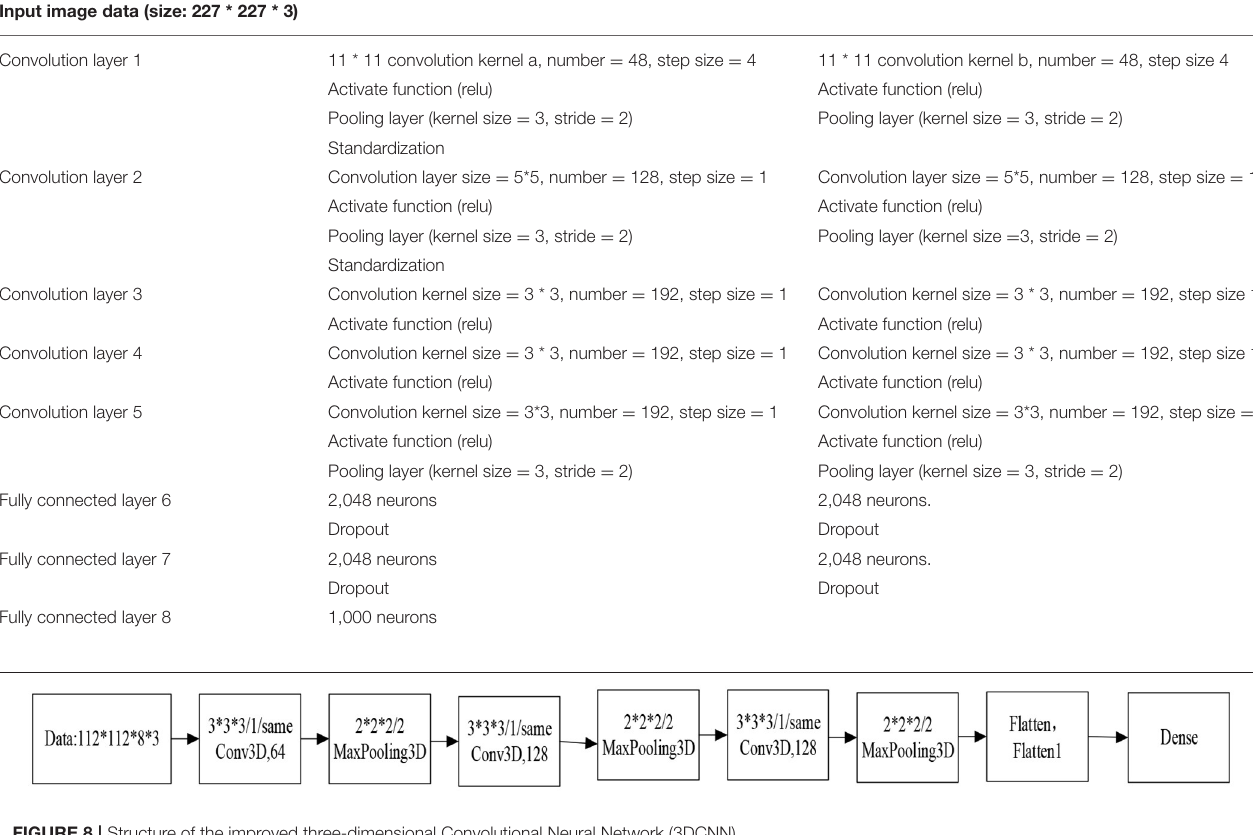
FIGURE 8 | Structure of the improved three-dimensional Convolutional Neural Network